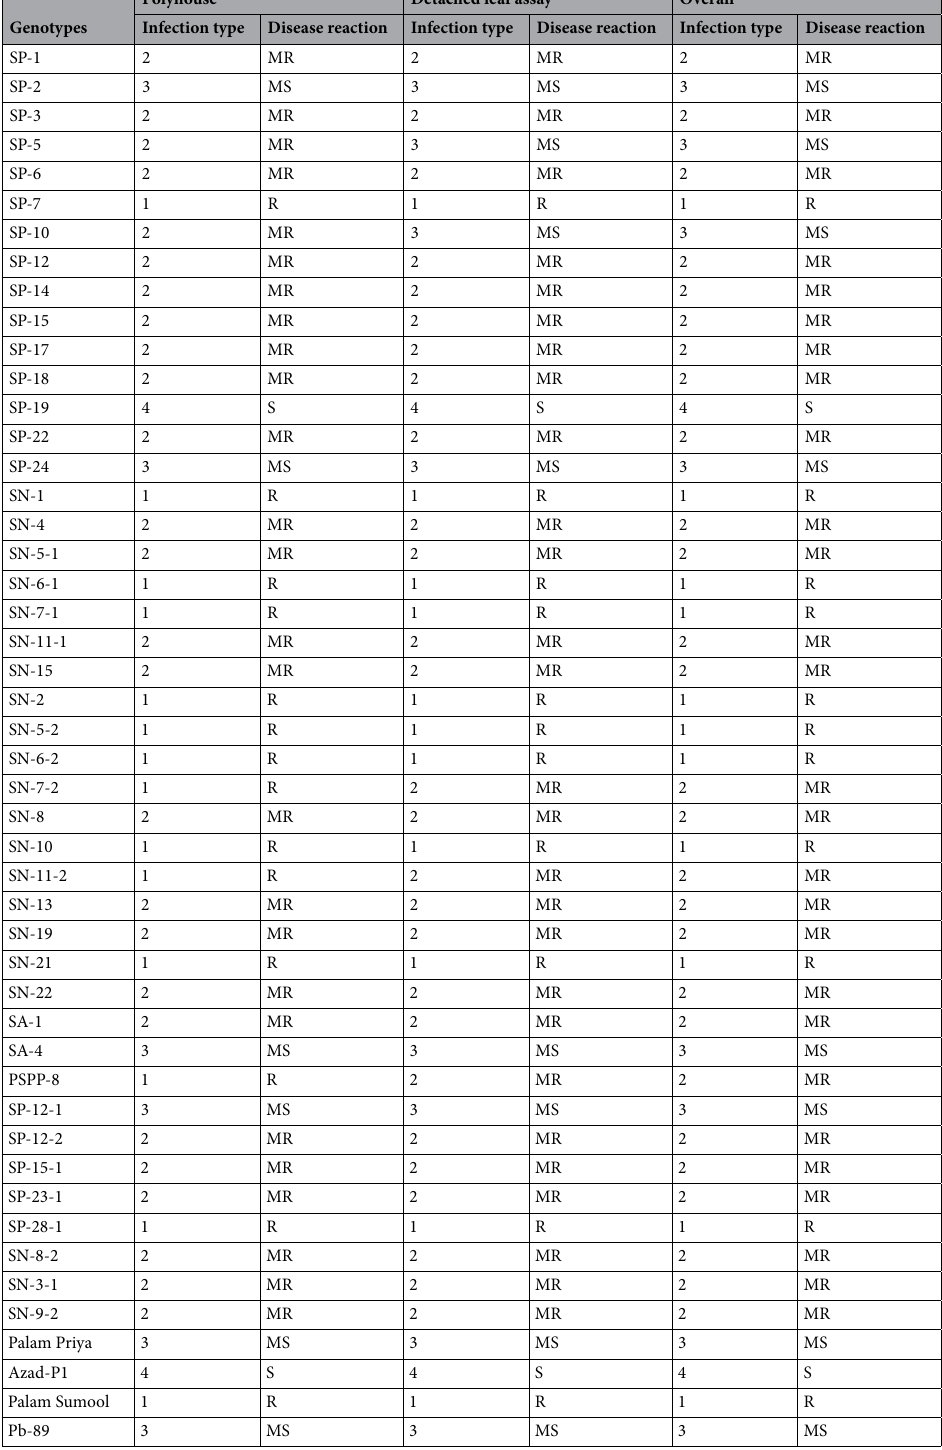
Table 6. Screening of the genotypes for powdery mildew incidence under in-vitro conditions. where R Resistant; MR Moderately resistant; MS Moderately susceptible; S